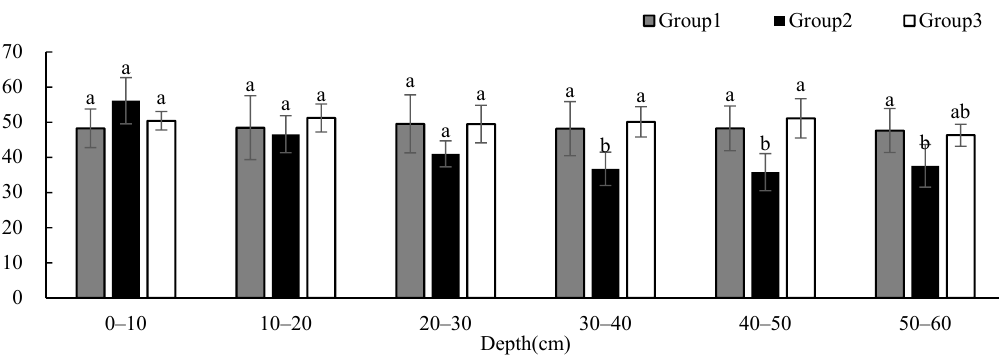
Figure 4. One-way ANOVA results of soil porosity under different vegetation cover types at differ- ent depths ( p < 0.05; a > b).